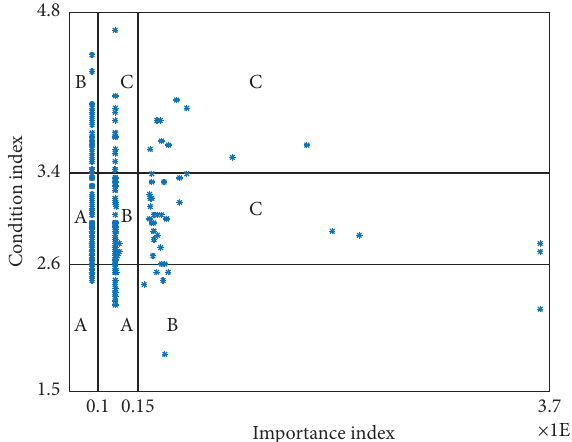
Figure 11: Priority of transmission line for maintenance planning. Table 5: No. of transmission lines zones in each area of Figure 11. Areas No. of transmission lines